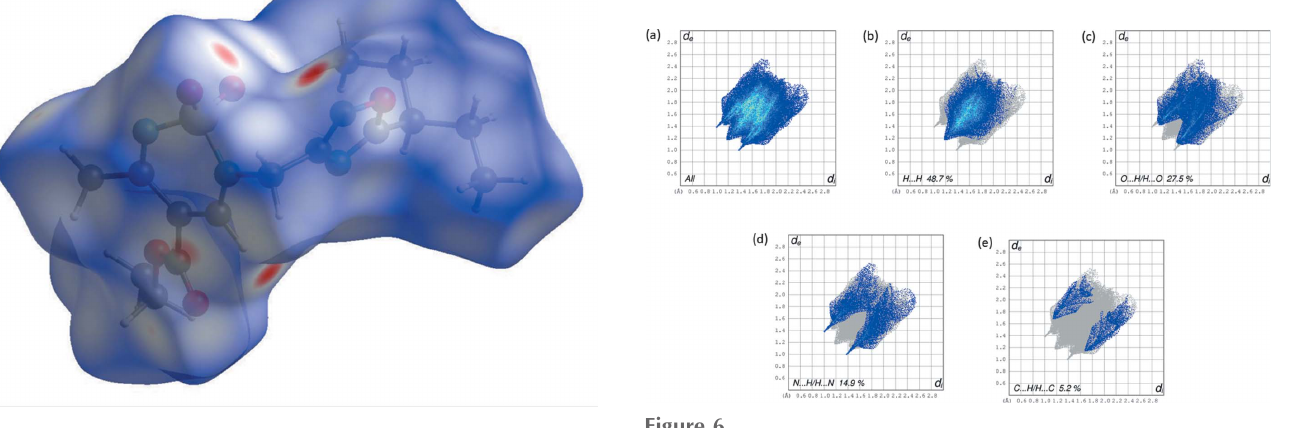
Figure 5 The Hirshfeld surface of compound 3 , mapped over d norm , with a fixed colour scale of (cid:4) 0.484 to 1.652 a.u.